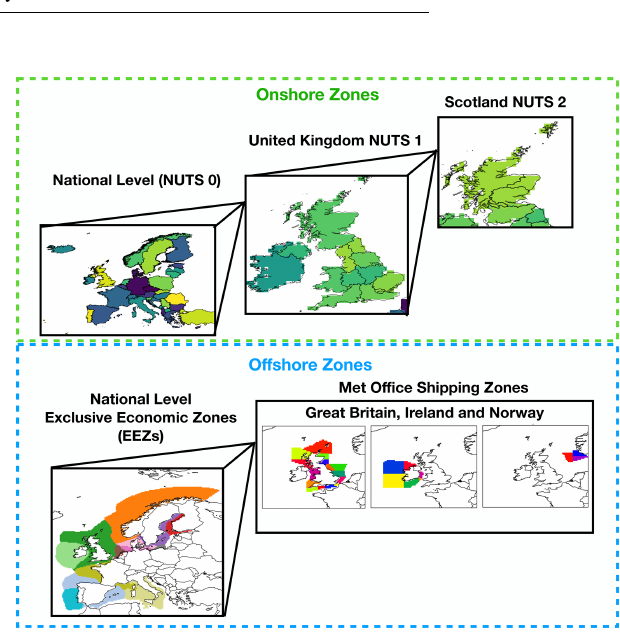
Figure 1. A schematic of the onshore (green box) and offshore (blue box) zones used in this study for aggregation of meteorologi- cal variables and capacity